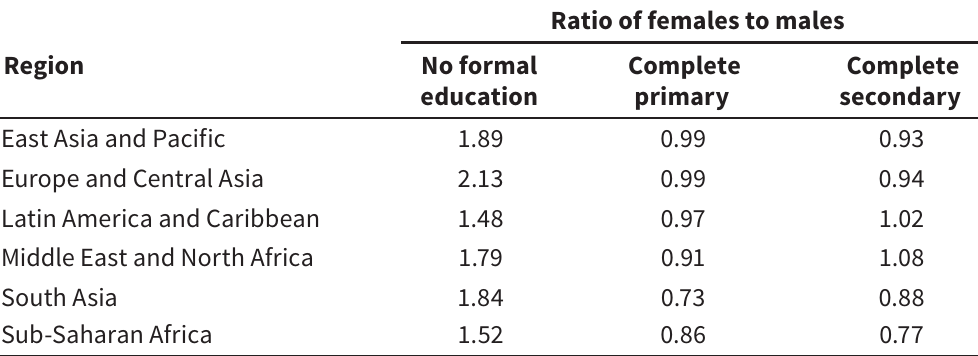
Ratio of Females to Males at Various Education Levels in 2010.